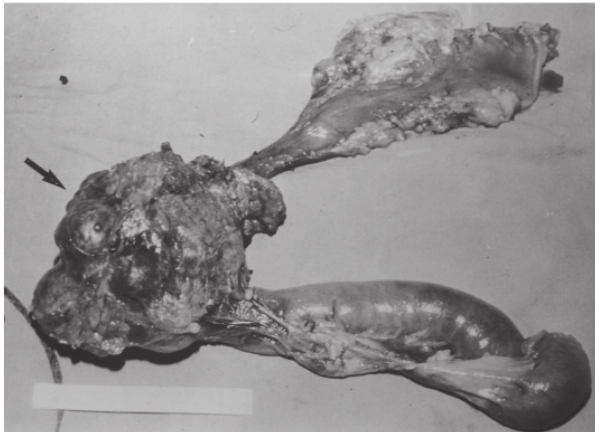
Figure 2 - Resected product of partial gastroduodenopancreatectomy (Whipple’s procedure) with a well-circumscribed nodular mass in the head of the pancreas (arrow)